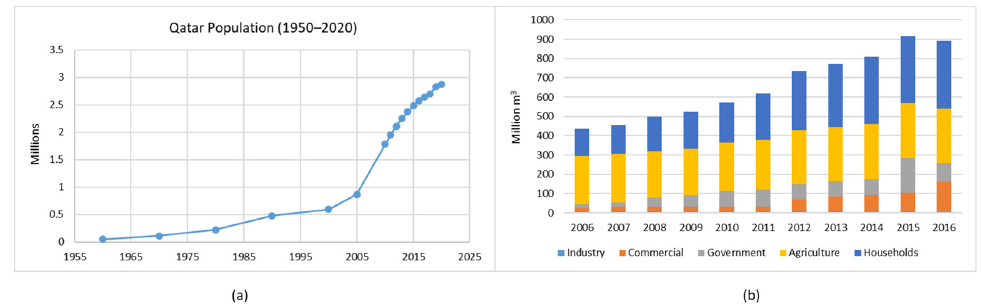
Figure 1. Increase in population ( a ) and increase in water use by economic sectors ( b ) in the State of Qatar. The major water end-use is associated with domestic use. Data excludes water loss in the network and the majority of water used in heavy industry and is compiled from various ministries overseeing utilities within Qatar [5].